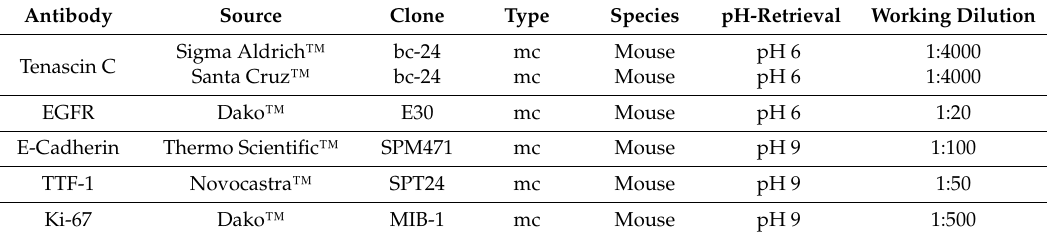
Table 3. List of primary antibodies, working dilutions and pH of antigen retrieval buffers